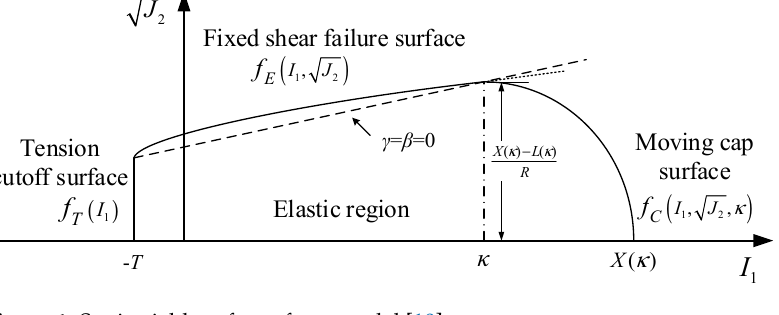
Figure 1. Static yield surface of cap model [10].